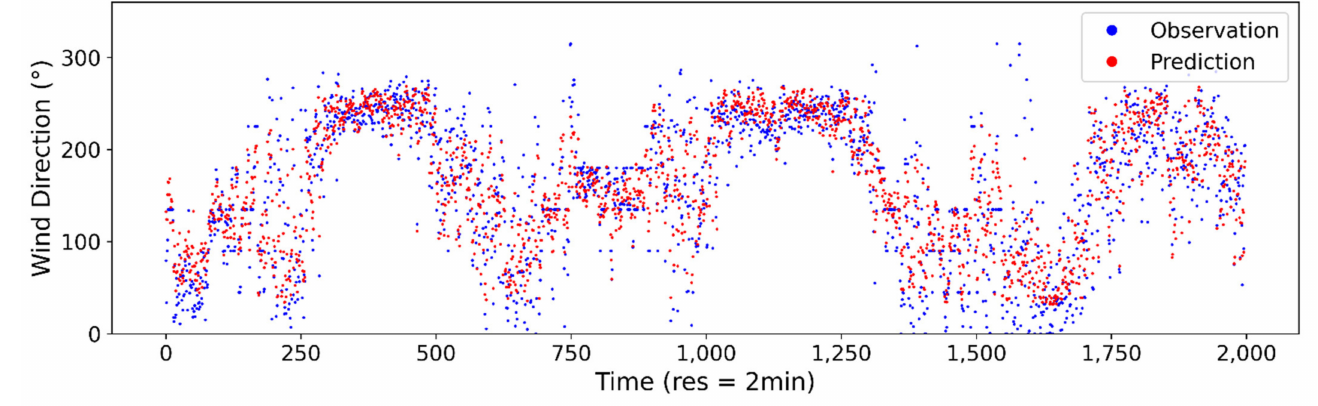
Figure A8. Estimated vs. observed wind direction at 2-min sampling interval using ANN model.